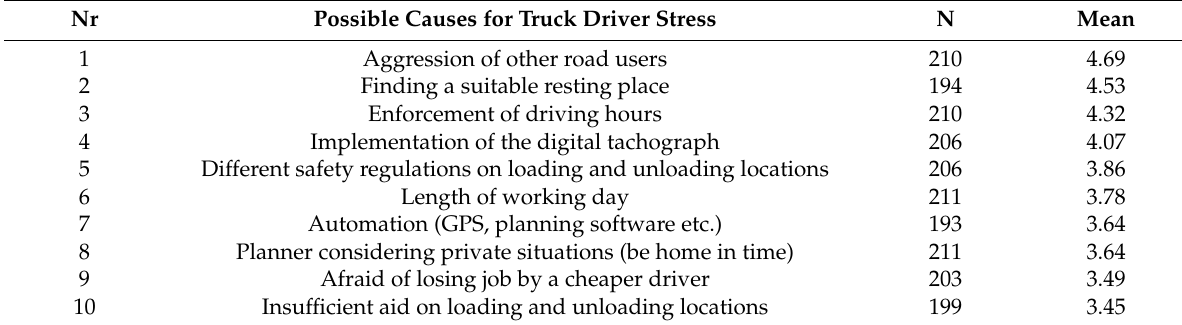
Table 2. Top 10 causes for truck driver stress and their ratings at